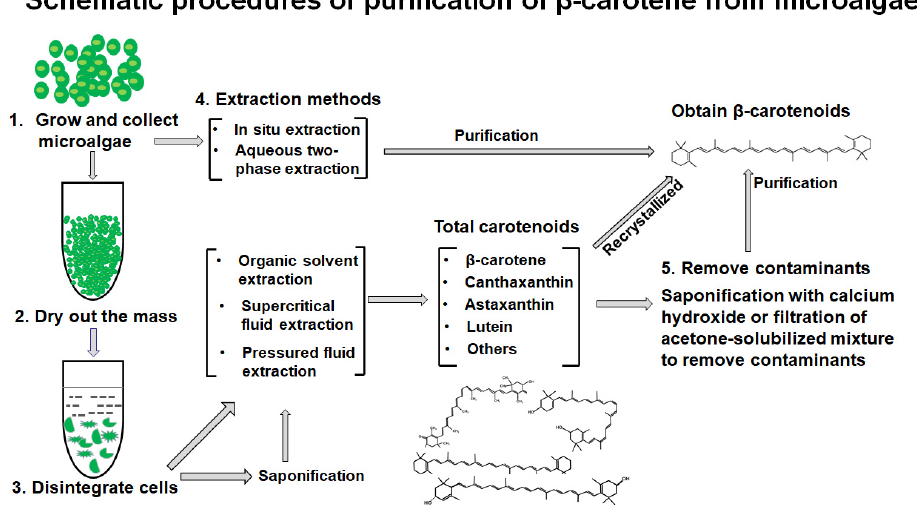
Figure 2. Flow chart of β -carotene extraction from Dunaliella salina . Microalgae are grown and collected (step 1), dried (step 2), and disintegrated (step 3). Step 4 is to extract total carotenoids using a